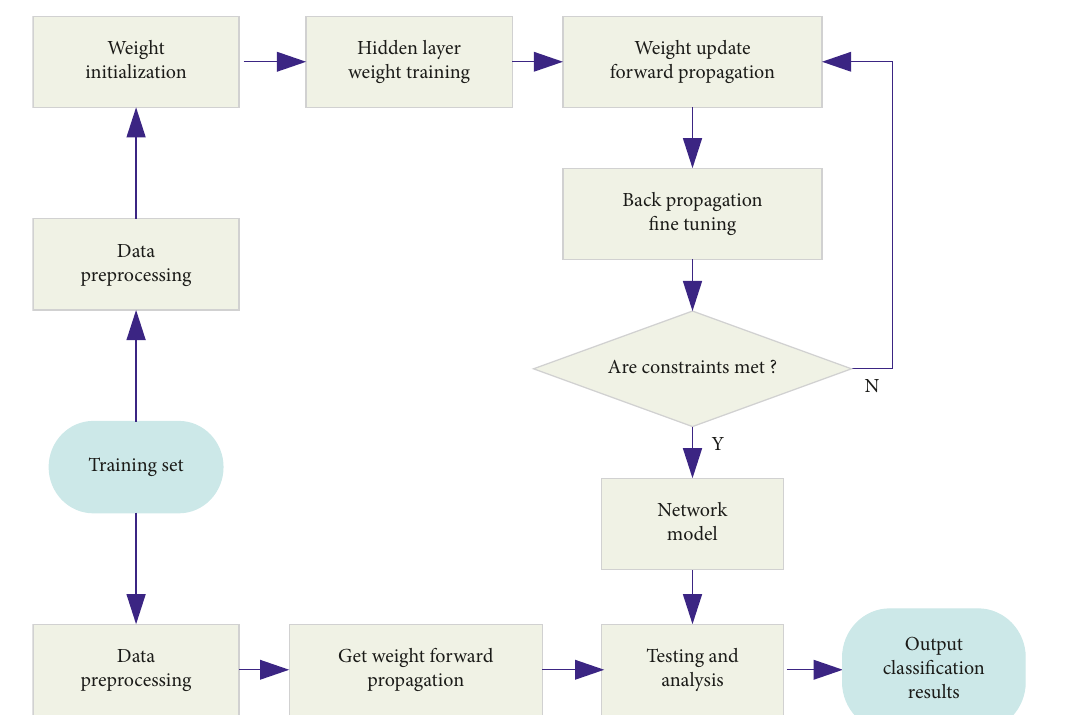
Figure 9: Working flow diagram of improved deep learning network